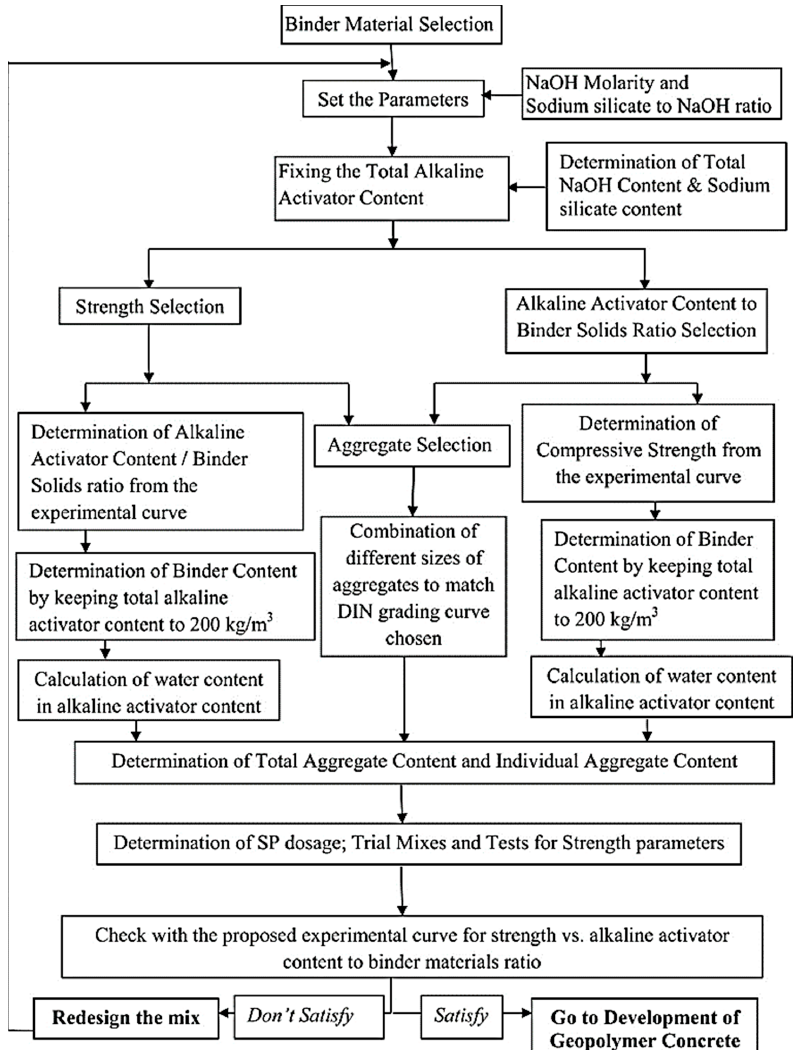
Figure 5. Flow chart representing mix design based on strength and activator to binder approach